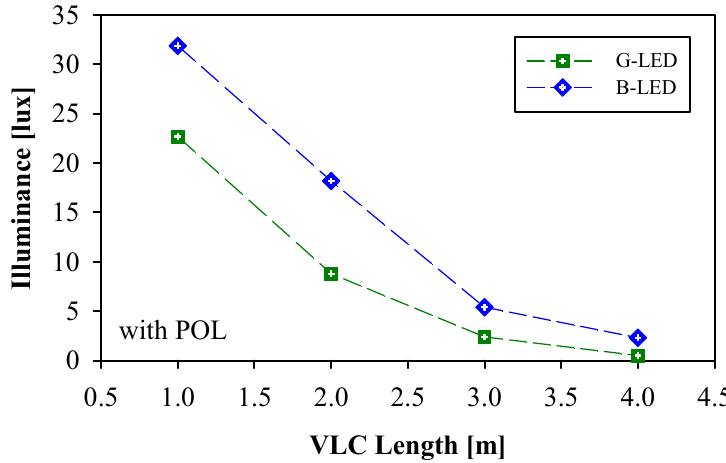
Figure 4. Measured corresponding illuminances of the G − and B − LEDs after passing through two POLs with parallel polarization before launching into the focusing lens.